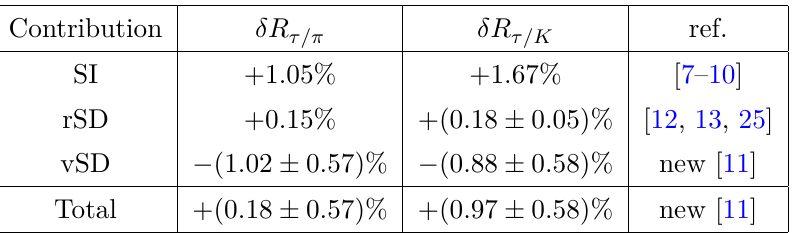
: Structure Independent τ/P